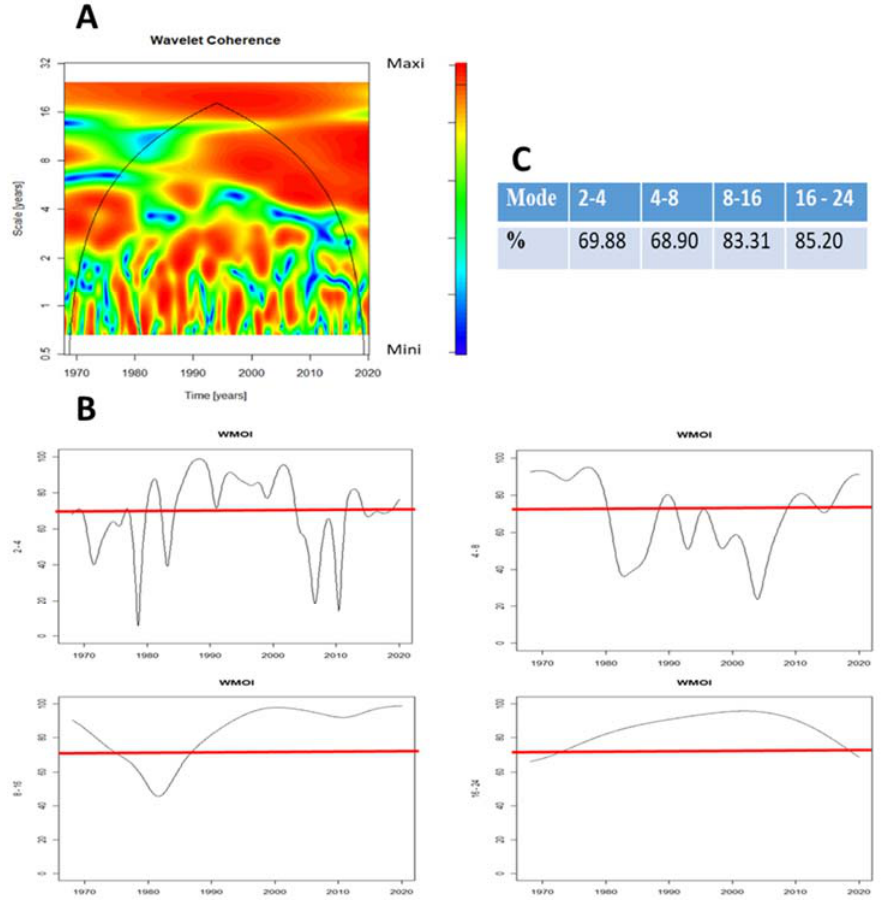
Figure 7. ( A )—Wavelet correlation between regional monthly average precipitation and WMOI in ‐ dex. ( B )—Wavelet correlation between regional monthly average precipitation and WMOI index